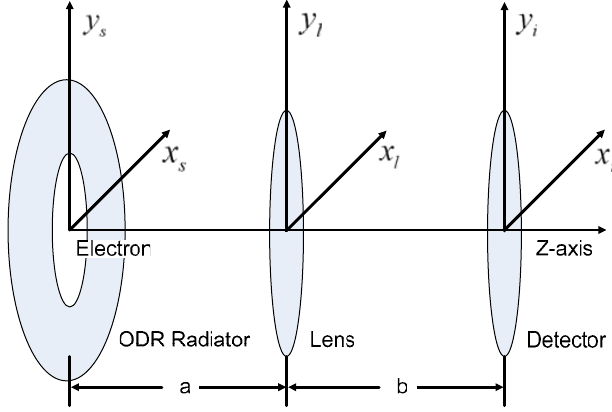
FIG. 1. (Color) Geometry for imaging with ODR from the circular